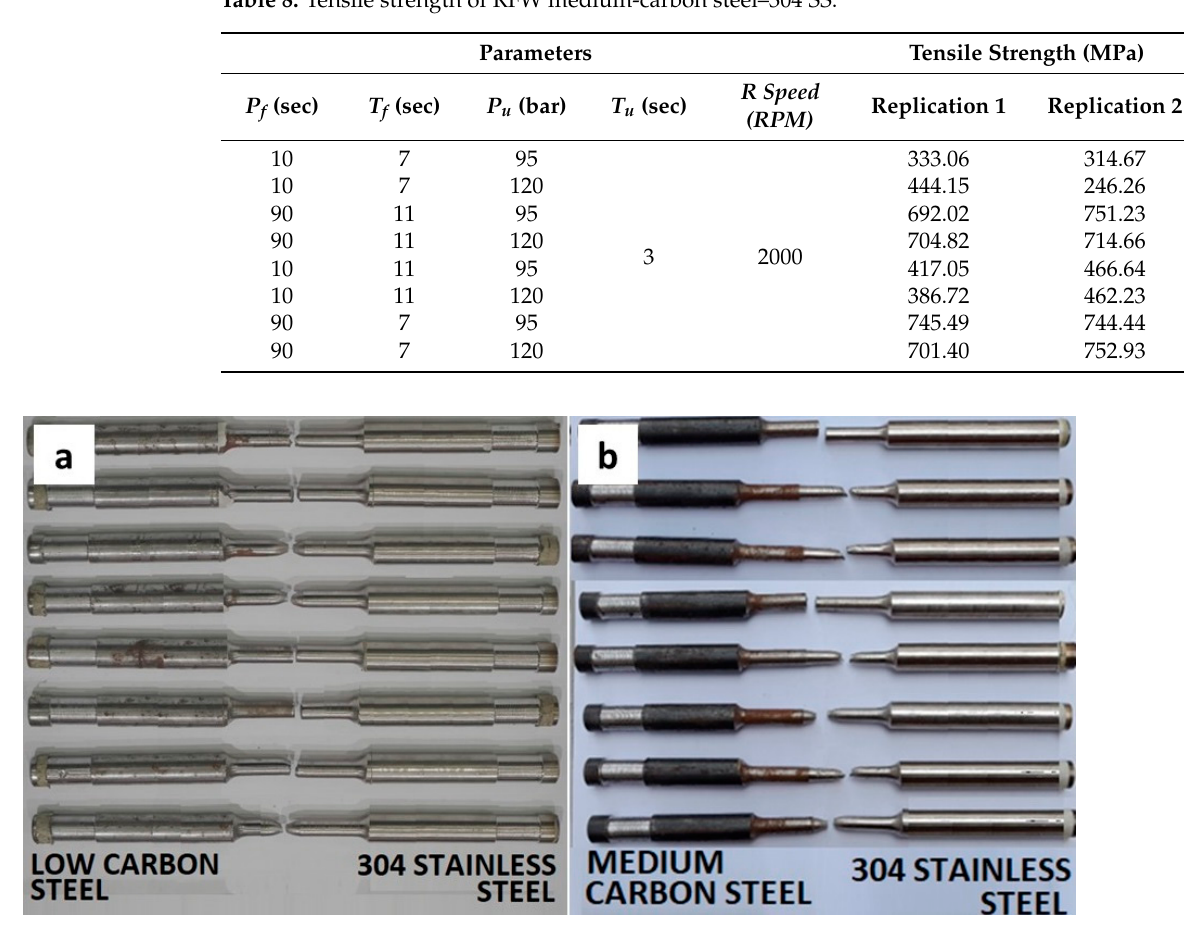
Figure 9. Broken specimens of low-carbon steel–304 SS ( a ) and medium-carbon steel–304 SS ( b ) after tensile testing.